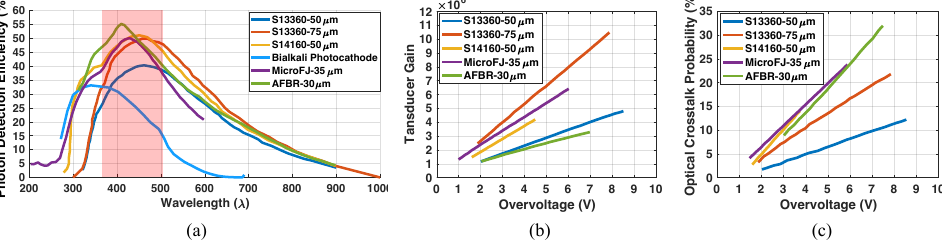
Figure 2. Photon detection efficiency, transducer gain, and optical crosstalk probability for various commercial silicon photomultipliers [7–10] (manufacturer’s data) are shown in ( a , b , c ), respectively. A red region is also highlighted in ( a ), denoting the luminescence emissions band of EJ-204 plastic scintillator